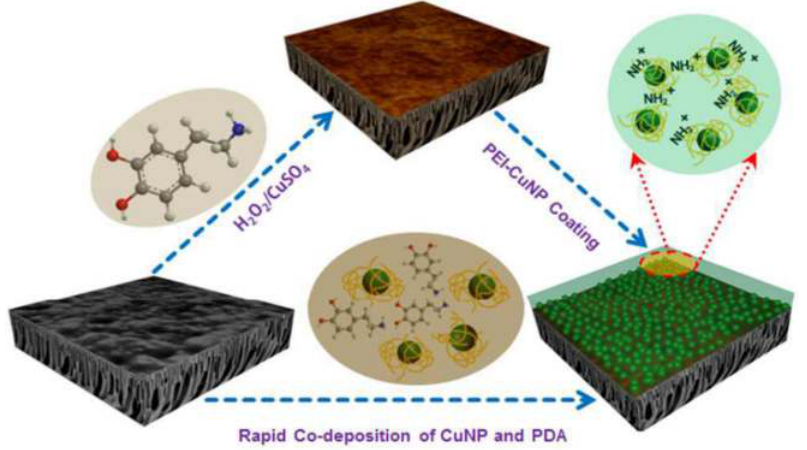
Figure 9. Schematic diagram of the surface modifications of the HPAN membrane via two-step deposition and co-deposition using PDA and CuNPs. Extracted from [64].